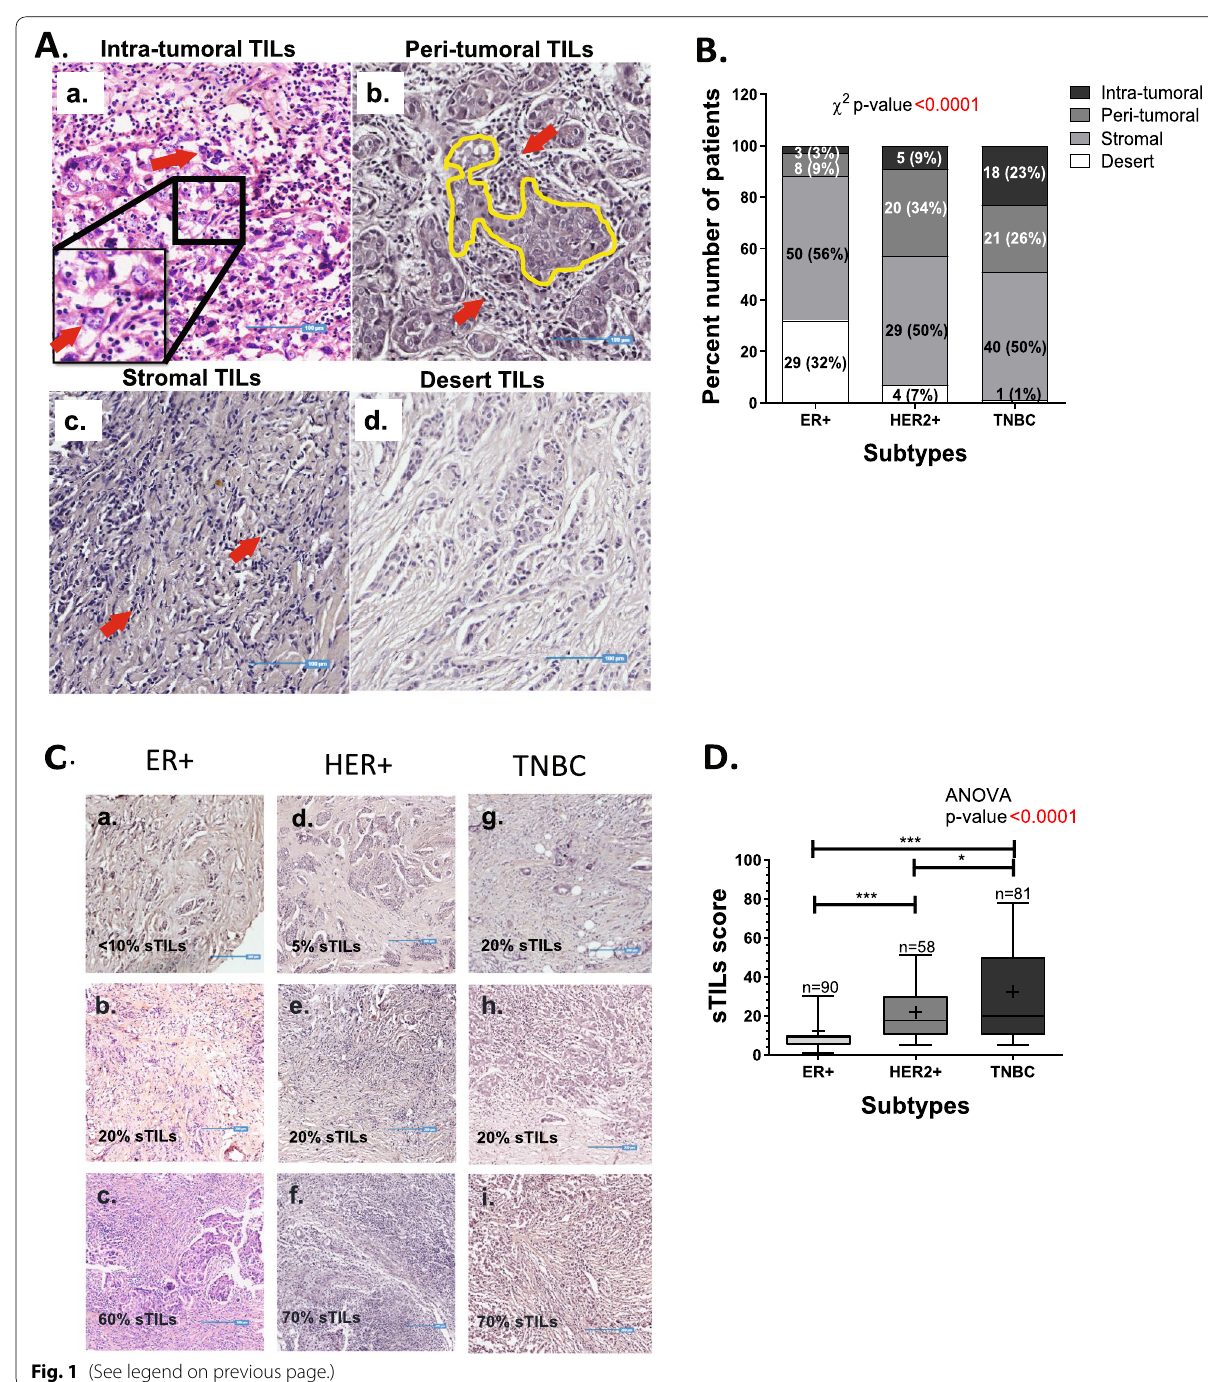
Fig. 1 (See legend on previous